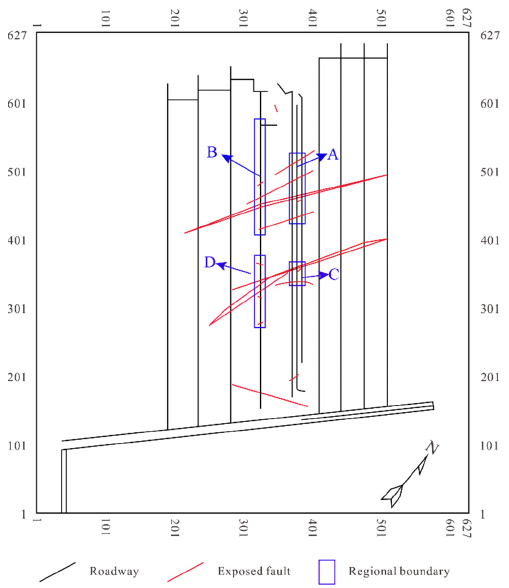
Figure 4. The plan of the mining